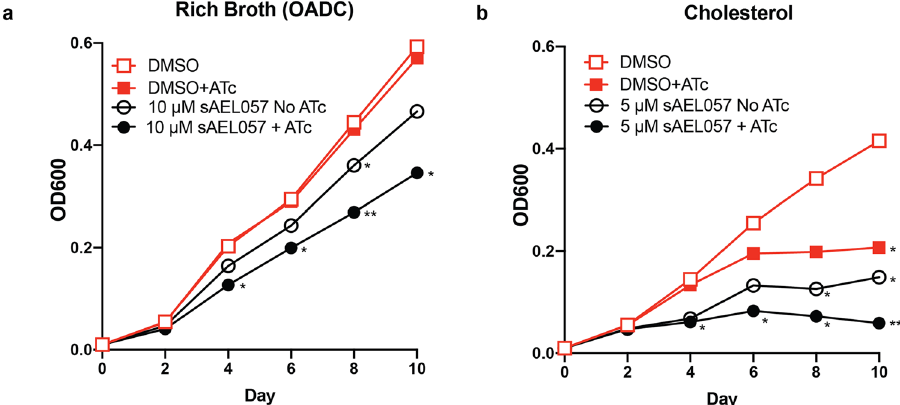
Fig. 5 Growth phenotype with knockdown of ideR is more pronounced in cholesterol vs rich broth conditions. IdeR knockdown strain was generated in Erdman Mtb using a CRISPRi construct. The knockdown strain was grown in media supplemented with OADC ( a ) or cholesterol ( b ) and OD 600 values were measured every 2 days. + ATc = induced ideR knockdown, no ATc = uninduced controls. Red lines: DMSO controls (no sAEL057). Black lines: sAEL057 treated at 10 µ M in OADC ( a ) or 5 µ M in cholesterol media ( b ). Statistical signi fi cance was assessed using a student ’ s unpaired t -test. Source data and P values for all main fi gures are available in Supplementary Data